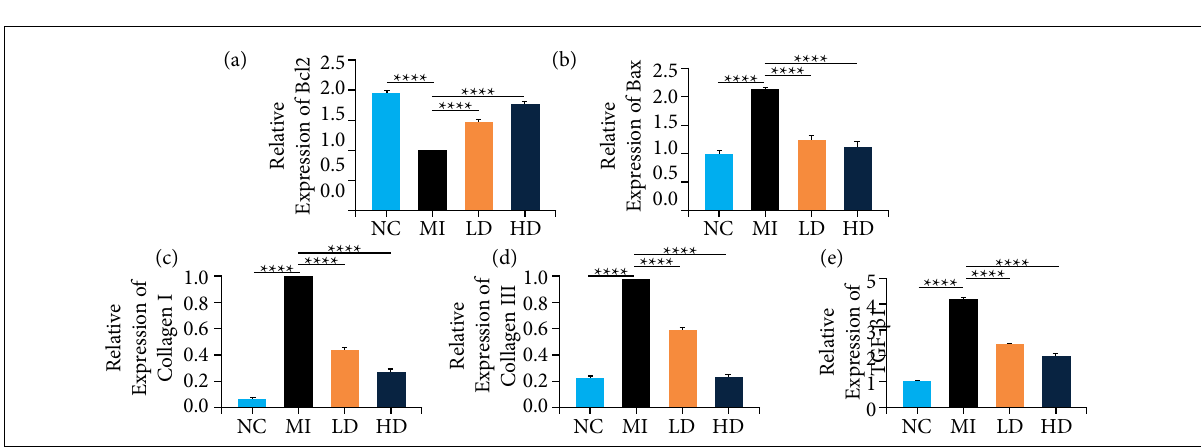
Figure 4 - Effect of jatrorrhizine on the expression of apoptosis and cardiac fibrosis-related proteins in mice. MI generated statistical downregulation in Bcl-2 mRNA and upregulation in Bax mRNA level, and these changes were partly recovered after been administration of jatrorrhizine (a, b) . MI resulted in statistical upregulation of collagen I, collagen III and TGF- β 1, which as significantly reduced by jatrorrhizine. NC: sham-operated mice received normal saline (c-e) .